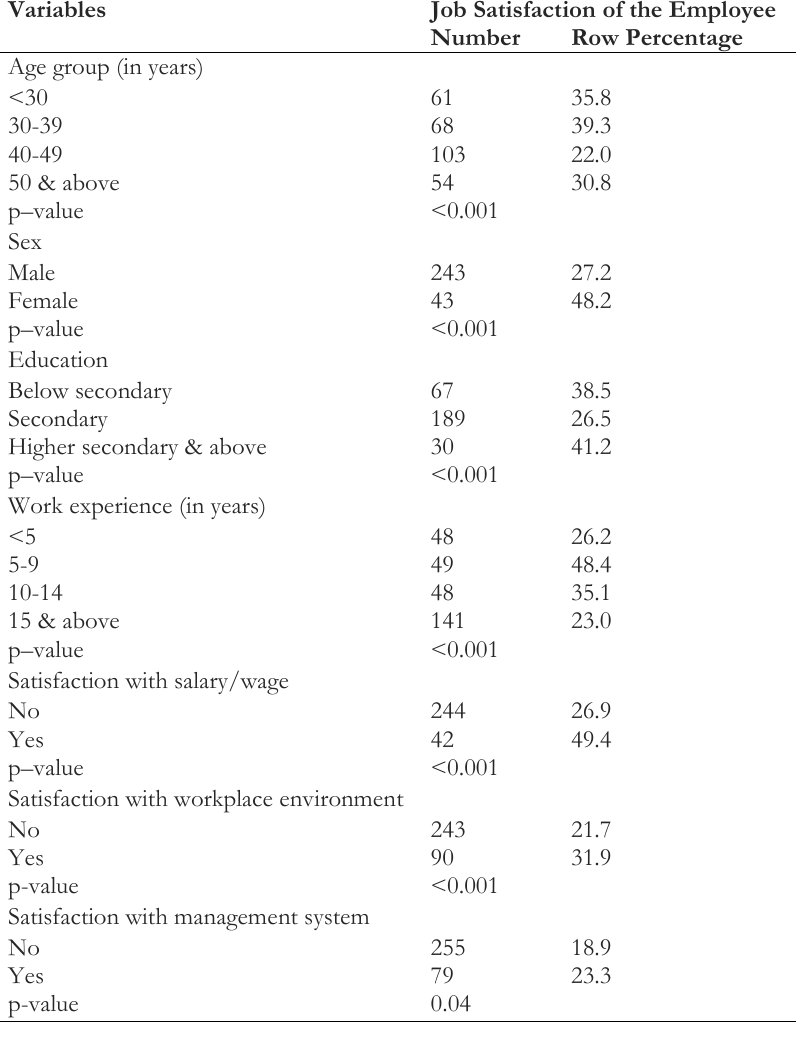
Table 2. Percentage of respondents by job